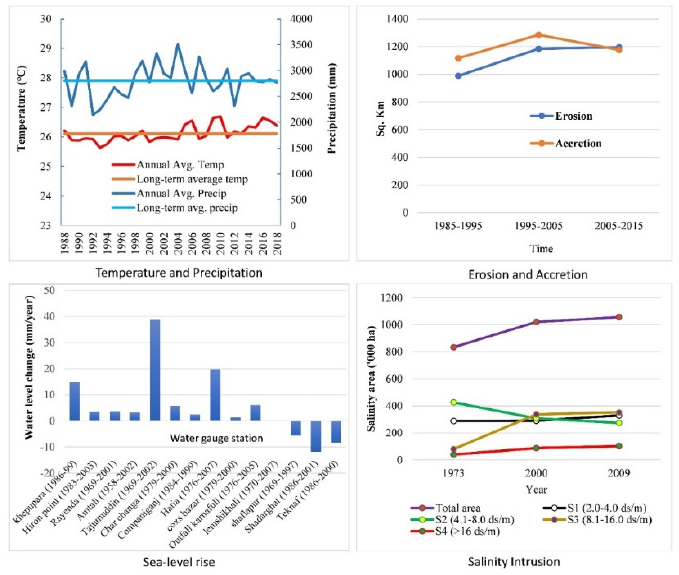
Figure 8. Historical changes in different climatic factors and their ecological consequences in CRB [28,58,67–69].